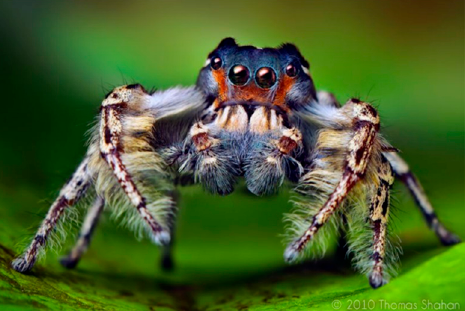
Figure 2. Salticidae Jumping Spider. Photography by Thomas Shahan (published under a CC BY 2.0 license).